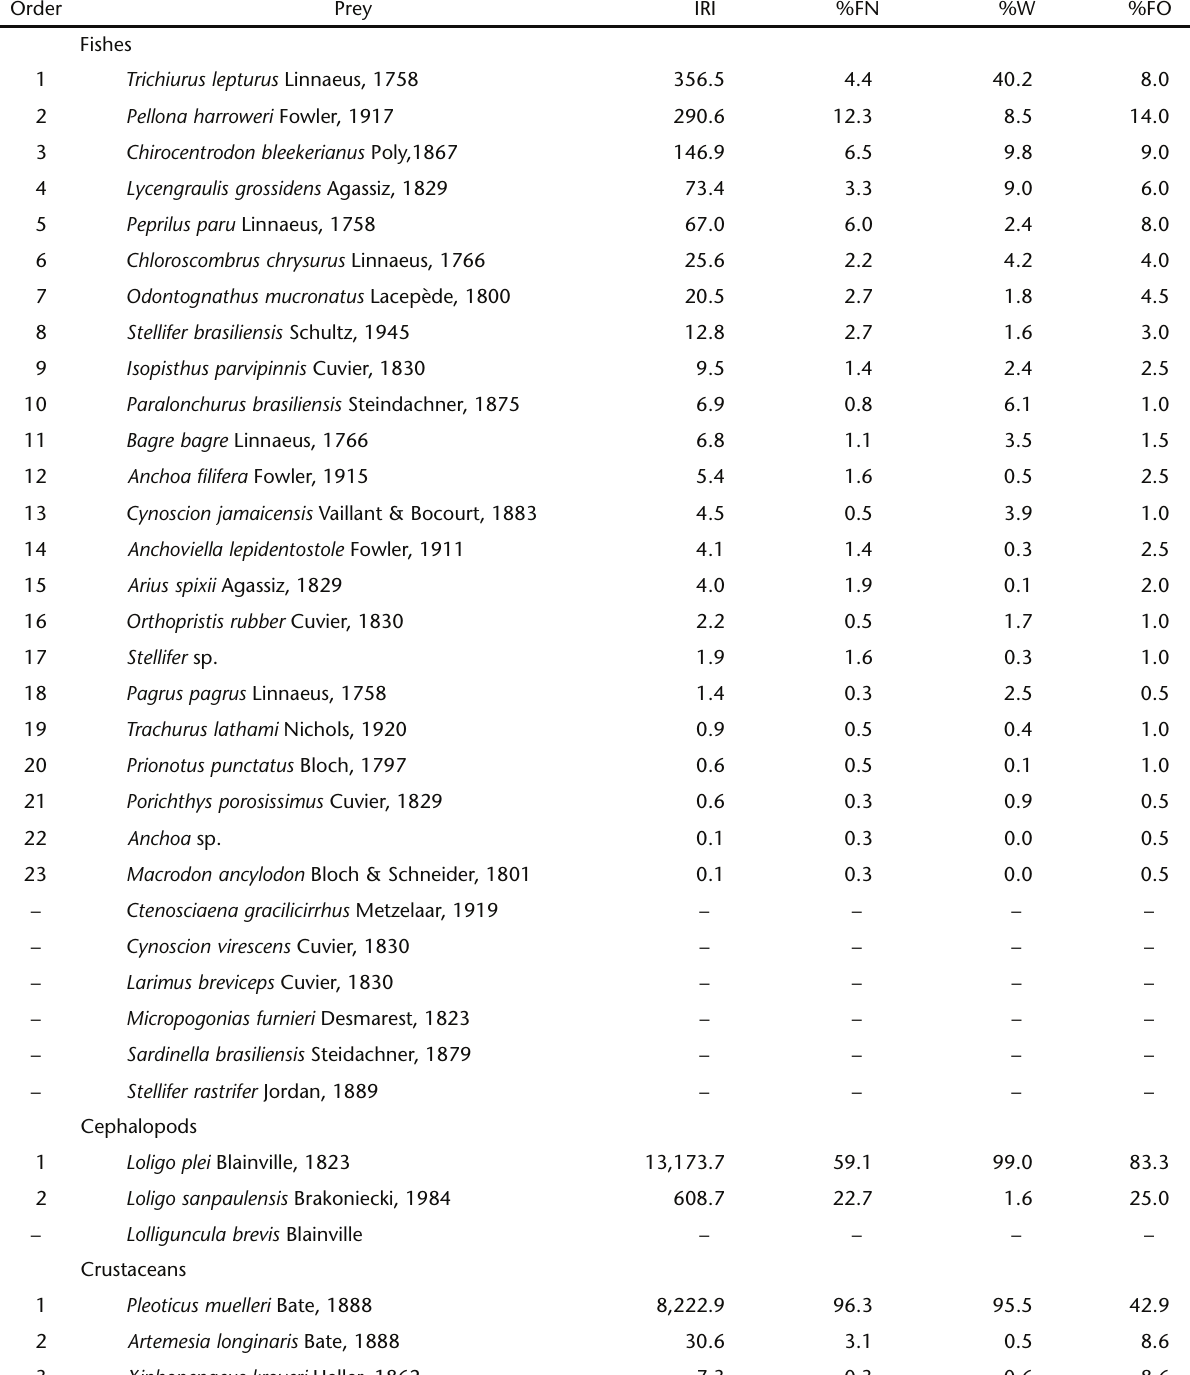
Table I. Prey species consumed by T. lepturus in northern Rio de Janeiro, with the Index of Relative Importance (IRI), numeric frequency (%FN), biomass (%W) and occurrence (%FO). Order Prey